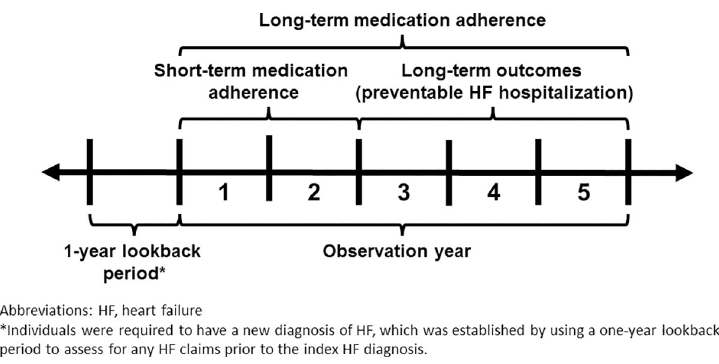
Fig 1. Definitions of the look-back period, short-term adherence, long-term adherence, and long-term preventable HF hospitalizations by observation years.